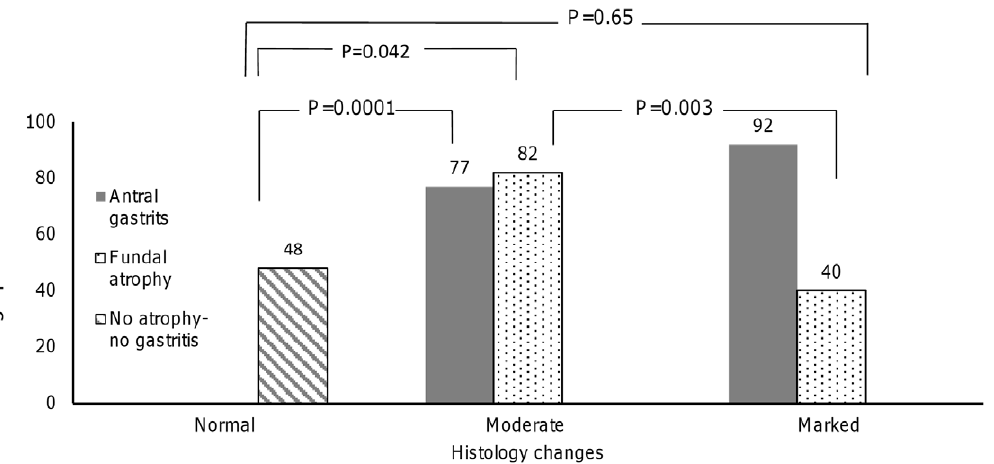
Figure 1. CagA + proportion among moderate and marked fundal atrophy (dotted bar) and antral gastritis (dark bar) in comparison with no-atrophy no gastritis (diagonal lined bar) subjects.